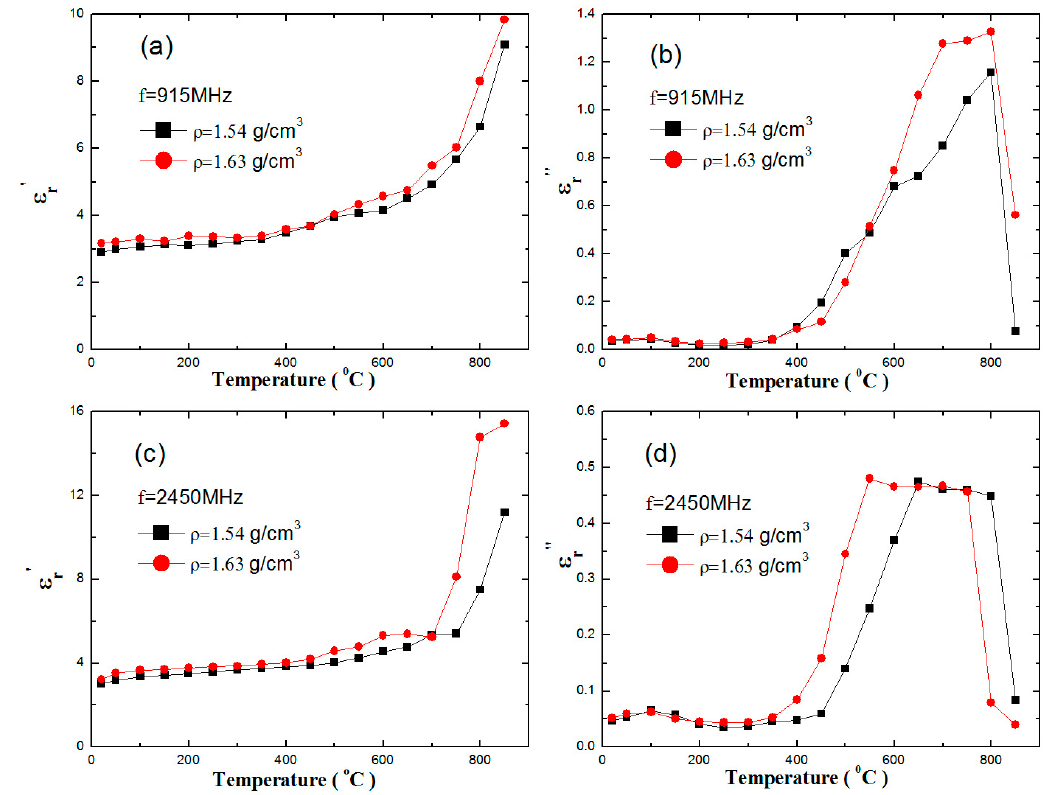
Figure 3. The variations of dielectric properties of zinc sulfide concentrate at different temperature.